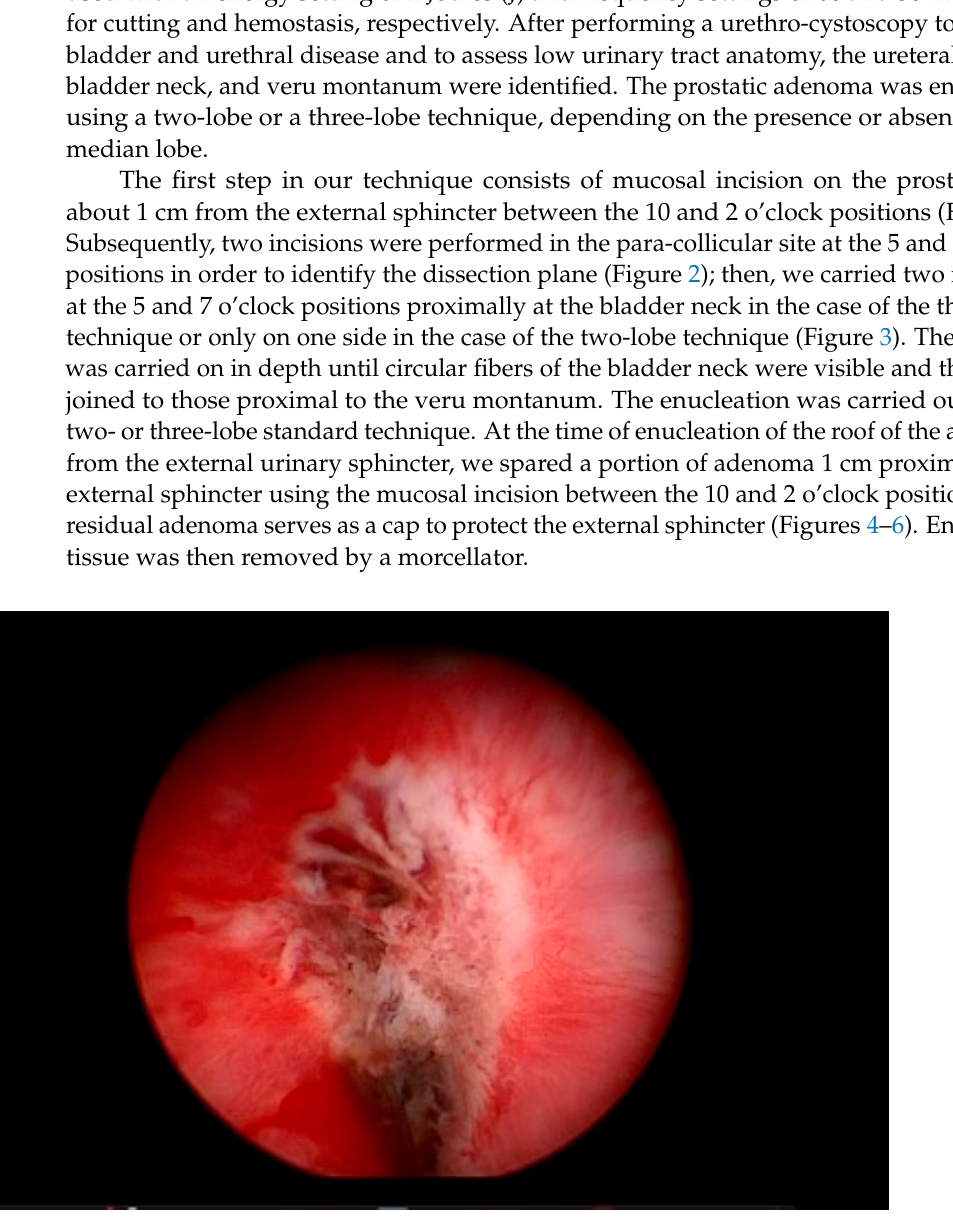
Figure 1. Laser mucosal incision on the prostate roof about 1 cm from the external sphincter between the 10 and 2 o’clock positions.